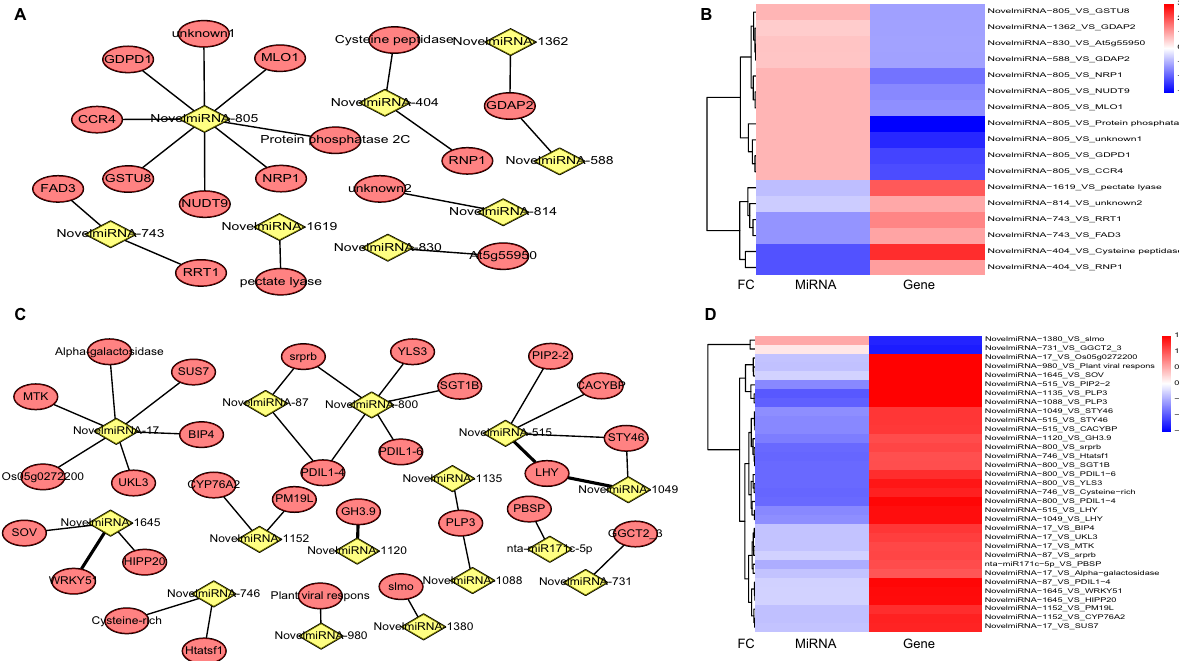
Figure 5. Novel miRNA-mRNA interaction network involved in nicotine metabolism. ( A ) Novel miRNA- mRNA interaction network in leaf. ( B ) Heatmap for mRNA and miRNA interaction pairs in leaf network. ( C ) Novel miRNA-mRNA interaction network in root. ( D ) Heatmap for mRNA and miRNA interaction pairs in root network. Yellow color represents miRNA candidates; Red color represents genes; RNP1 Heterogeneous nuclear ribonucleoprotein 1, GDPD1 Glycerophosphodiester phosphodiesterase, CCR4 Serine/threonine- protein kinase-like protein, RRT1 Rhamnogalacturonan I rhamnosyltransferase 1, NRP1 Nodulin-related protein 1, FAD3 Omega-3 fatty acid desaturase, NUDT9 Nudix hydrolase 9, MLO1 Nudix hydrolase 9, PLP3 Patatin-like protein 3, PDIL Protein disulfide isomerase-like, LHY Late elongated hypocotyl and circadian clock associated-1-like, srprb Signal recognition particle receptor subunit beta, Htatsf1 HIV Tat-specific factor 1 homolog, STY46 Serine/threonine-protein kinase, CACYBP Calcyclin-binding protein, GH3.9 Putative indole- 3-acetic acid-amido synthetase, SUS7 Sucrose synthase 7, GGCT2;3 Gamma-glutamylcyclotransferase 2–3, MTK Methylthioribose kinase, HIPP20 Heavy metal-associated isoprenylated plant protein